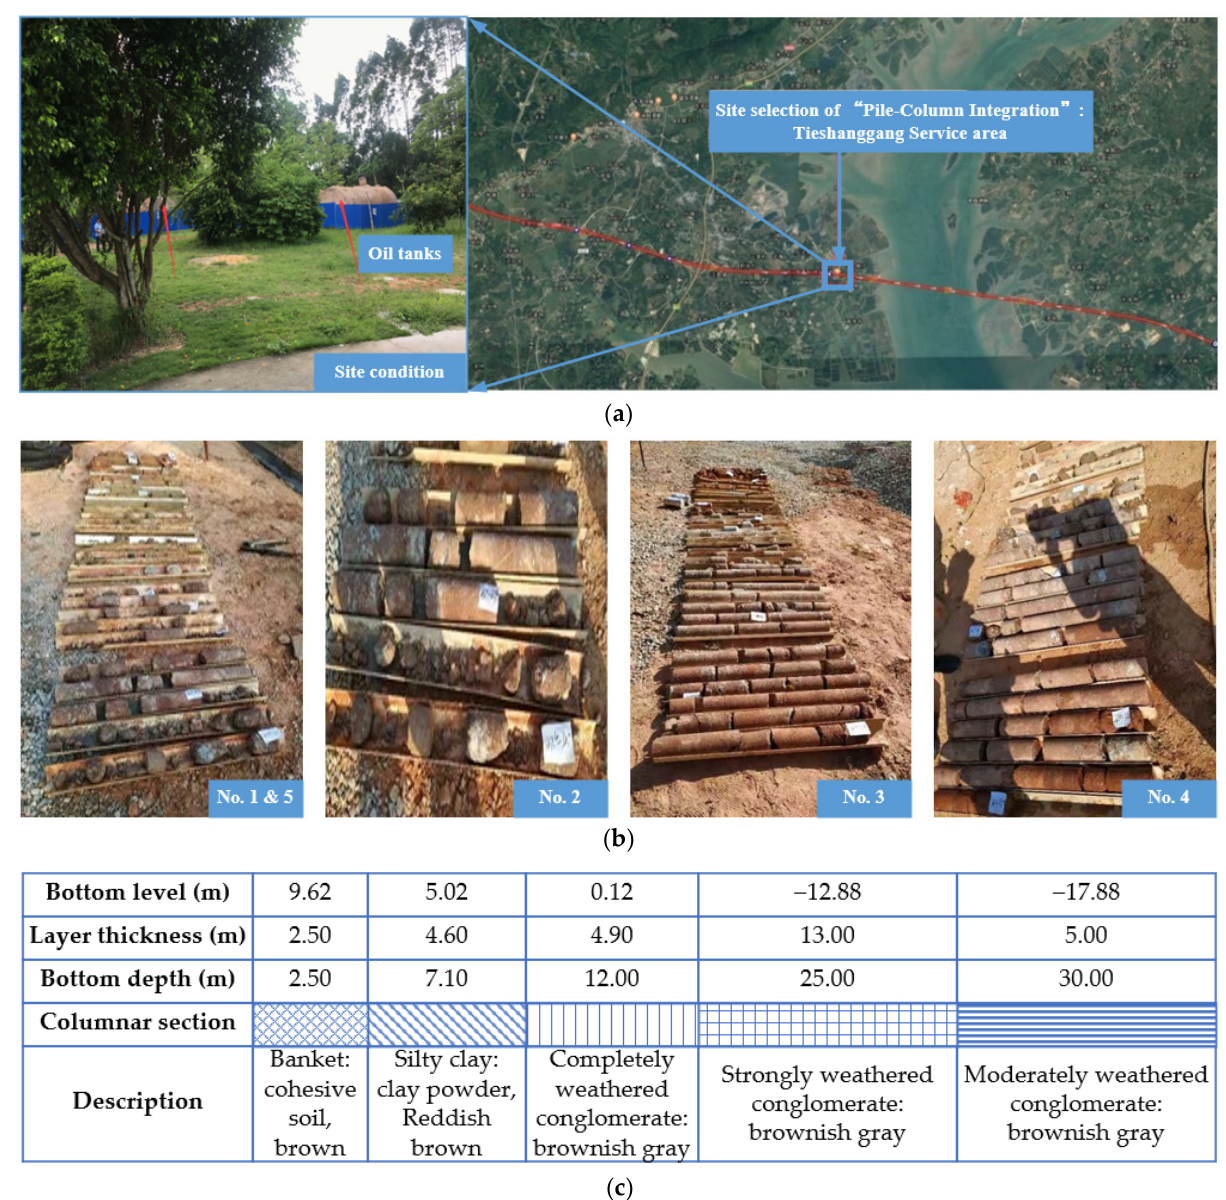
Figure 1. Application project for “Pile–Column Integration”: ( a ) schematic diagram of site selection and site conditions; ( b ) core samples of rock and soil; and ( c ) the basic parameters of soil.